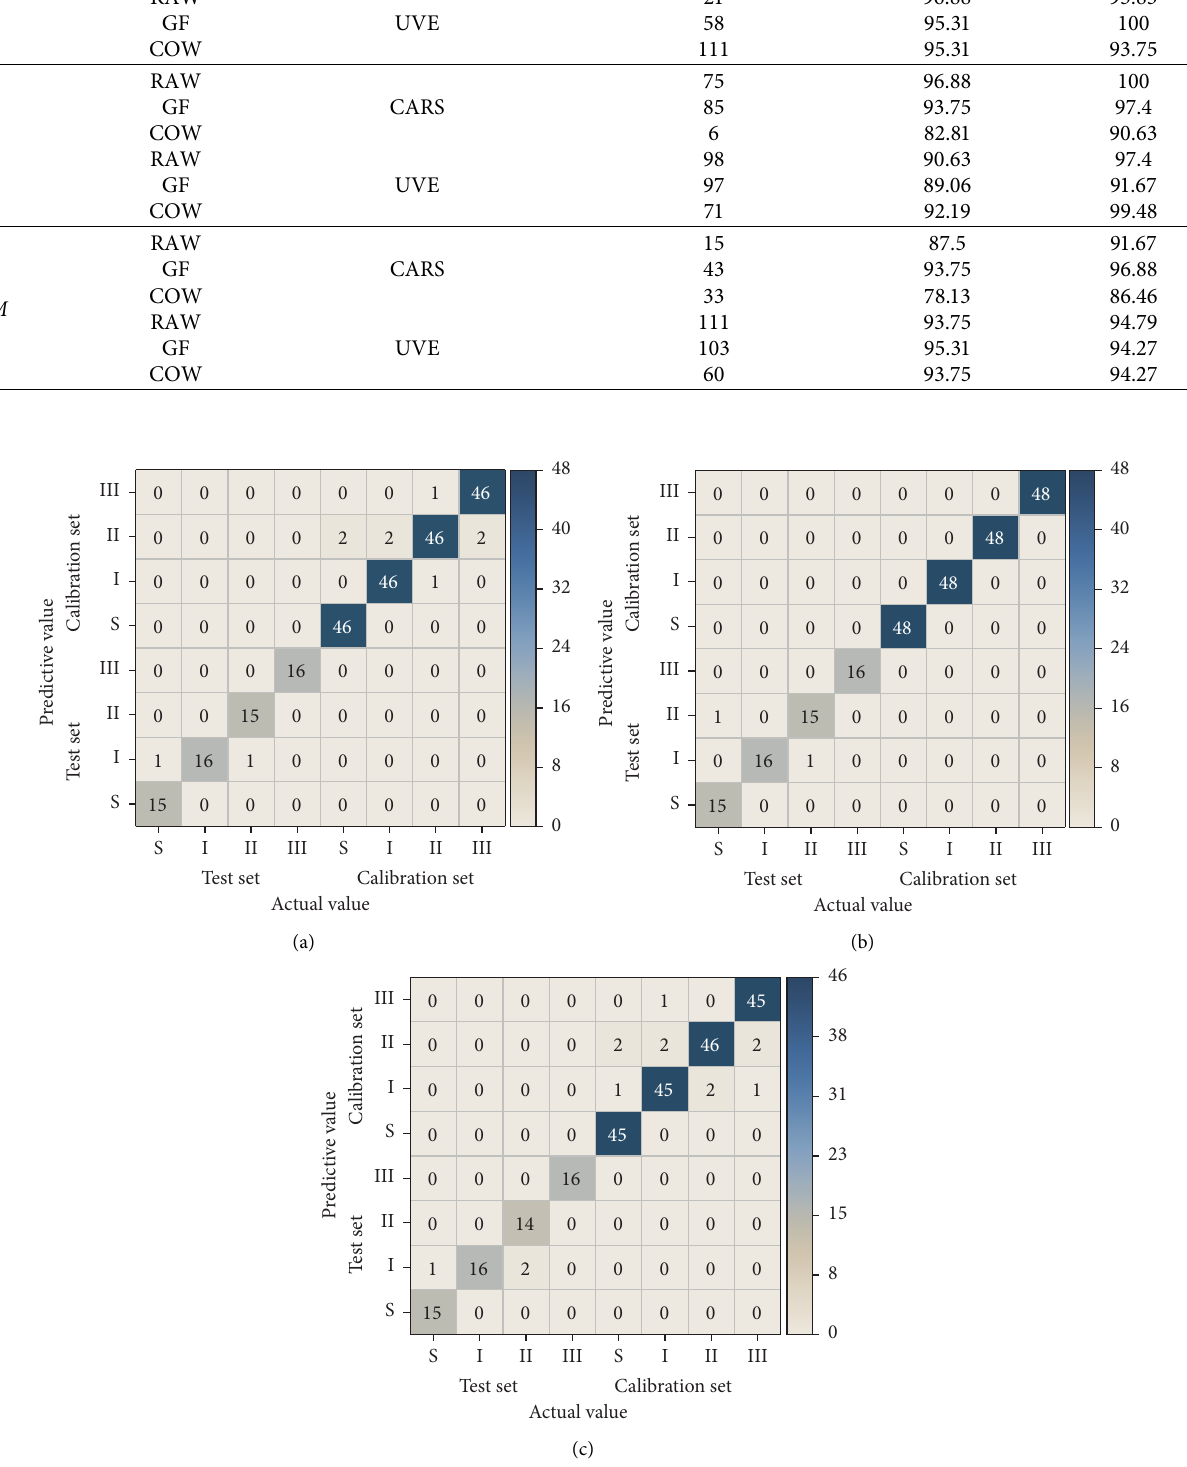
Figure 11: Confusion matrix of the optimal SVM model discrimination results based on R , A, and K - M spectra after wavelength selection. Confusion matrix for the discriminant results of the (a) R-RAW-UVE-SVM model, (b) A-RAW-CARS-SVM model, and (c) K-M-GF-UVE- SVM